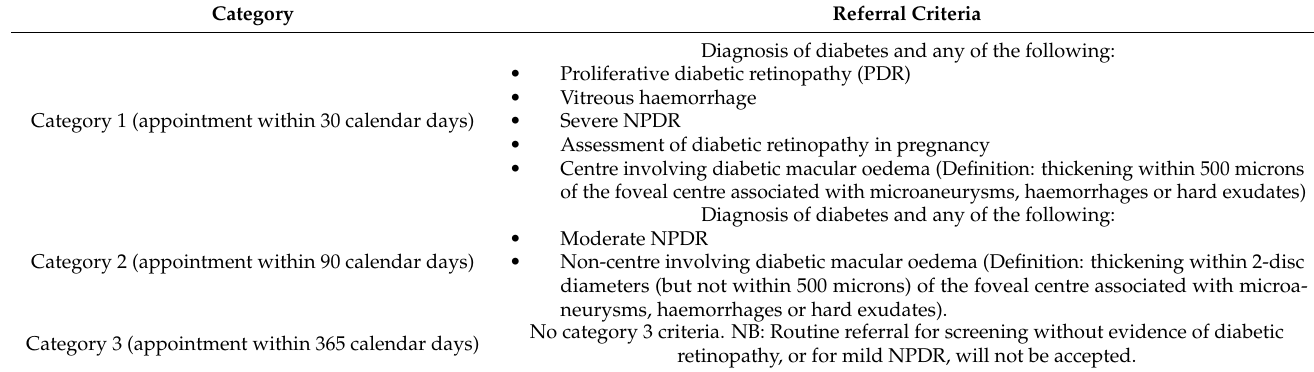
Table 2. CPC for ophthalmology’s under diabetic retinopathy condition and minimum referral criteria